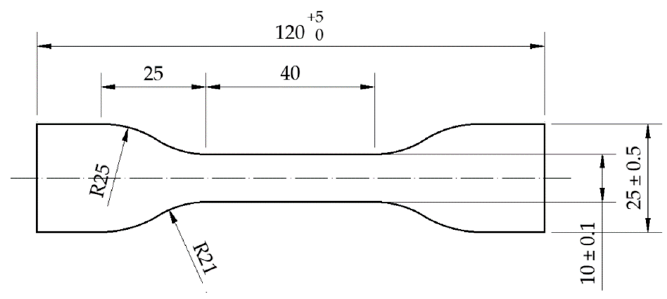
Figure 5. Sample dimensions in mm.